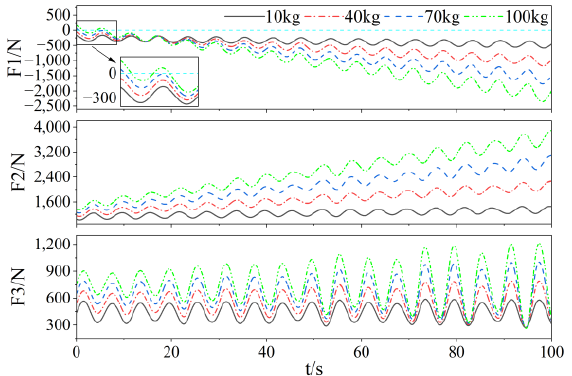
Figure 15. Tractive force of each drive support chain of the stable platform under personnel masses of 10 kg, 40 kg, 70 kg and 100 kg, respectively.